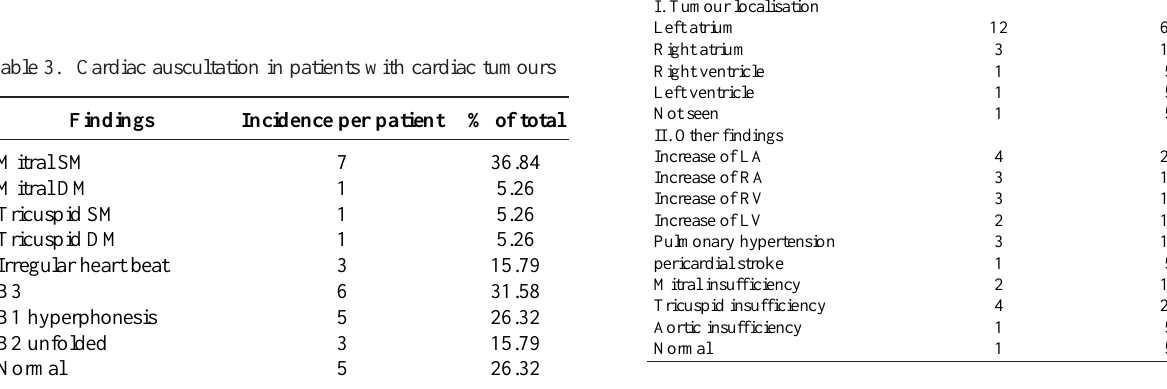
SM- systolic murmur; DM – diastolic murmur; B1- primary noise; B2- secondary noise; B3- tertiary noise.